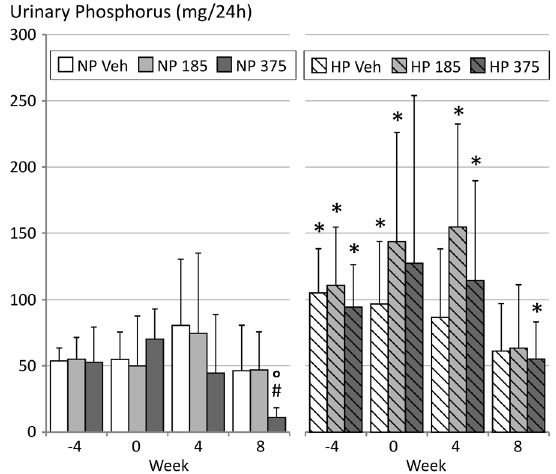
Figure 3. Urinary phosphorus levels in 5/6 th nephrectomized rats on a normal (NP) or high phosphorus (HP) diet treated with either vehicle (veh), 185 or 375 mg/kg/day CaMg. *: p , 0.05 vs NP, same dose; # : p , 0.05 vs vehicle, same diet; u : p , 0.05 vs week 2 4, same diet and dose.